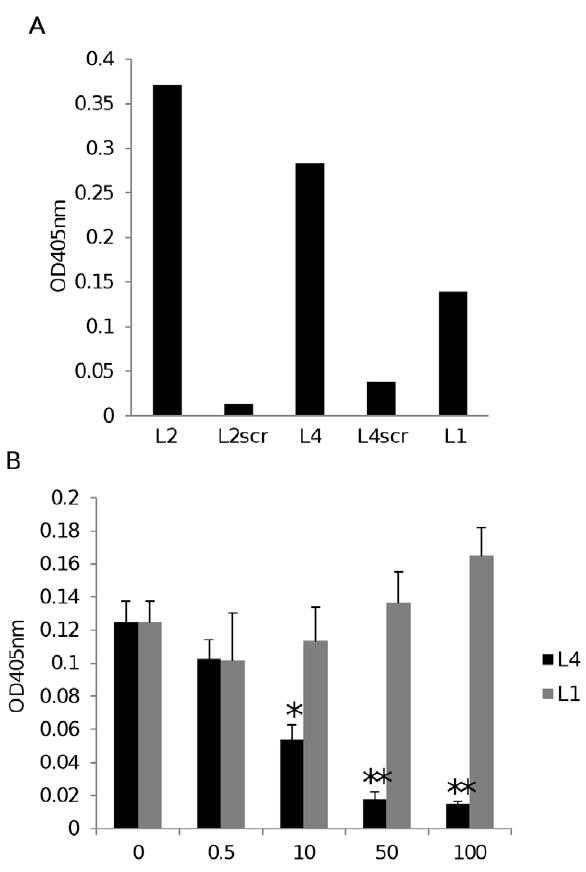
Figure 3. PorA loop 4 and OmpP2 loop 2 peptides bind LamR. (A) Binding of LamR to OmpP2 loop 2 (labeled L2), OmpP2 loop 2scr (L2scr), PorA loop 4 (L4), PorA loop 4scr (L4scr) or PorA loop 1 (L1) coated ELISA plates. Results shown are means of triplicate wells from a representative example from two independent experiments. (B) Binding of DIG-labeled LamR to PorA 20–392 in the presence of 0.5, 10, 50 or 100 m g of peptide corresponding to PorA loop 4 (L4) or loop 1 (L1). The binding of LamR to PorA 20–392 in the absence of peptide served as a negative control for inhibition. * p , 0.05 compared to binding in the absence of peptide. ** p , 0.01 compared to binding in the absence of peptide. Data shown are means from three independent experiments; in each experiment each sample was tested in triplicate. Error bars indicate SEM.